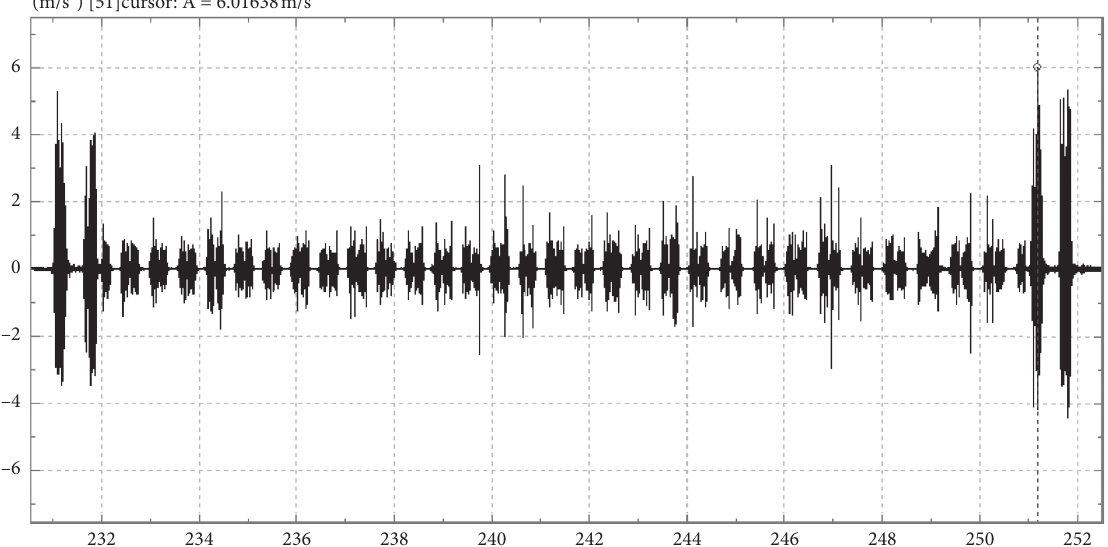
Figure 20: Time domain characteristic diagram of vibration acceleration along the vibration direction ( Z -axis) in the fracture